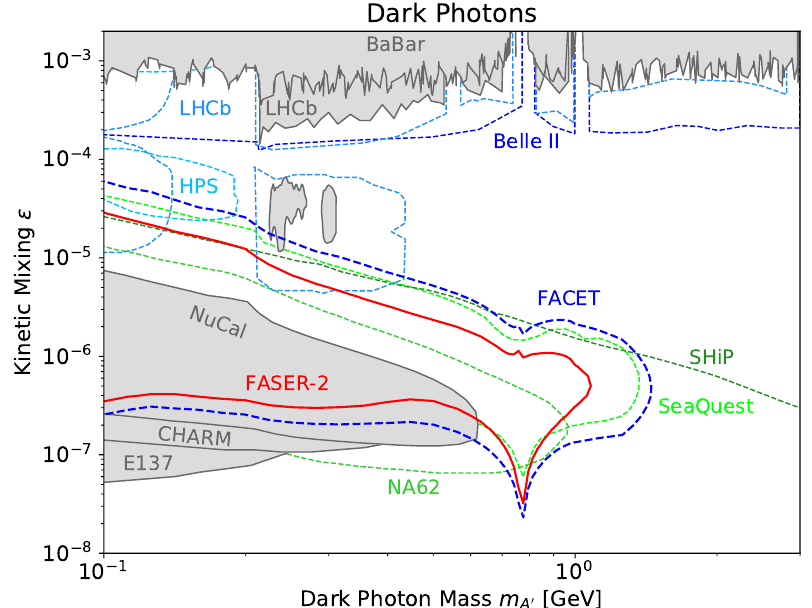
Figure 2 . FACET reach for dark photons (3 event contours) in a generic model with no BSM sources, as calculated with Foresee [38]. Existing bounds (gray shaded regions) are taken